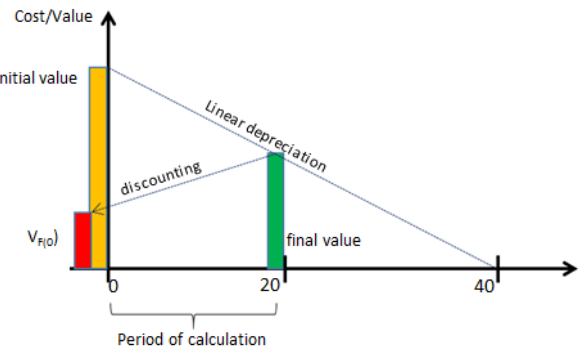
Figure 4. Methodology to calculate the residual value.